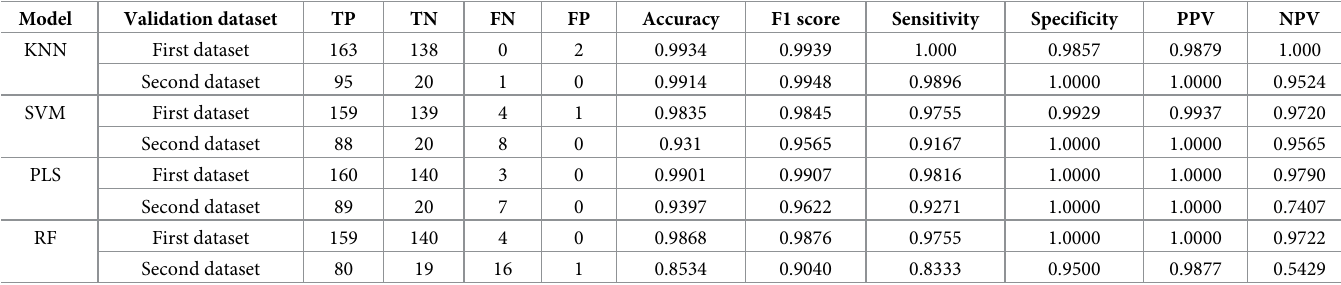
Table 2. Performance of various machine learning models for the detection of Corsican hybrids on first and second validation datasets.